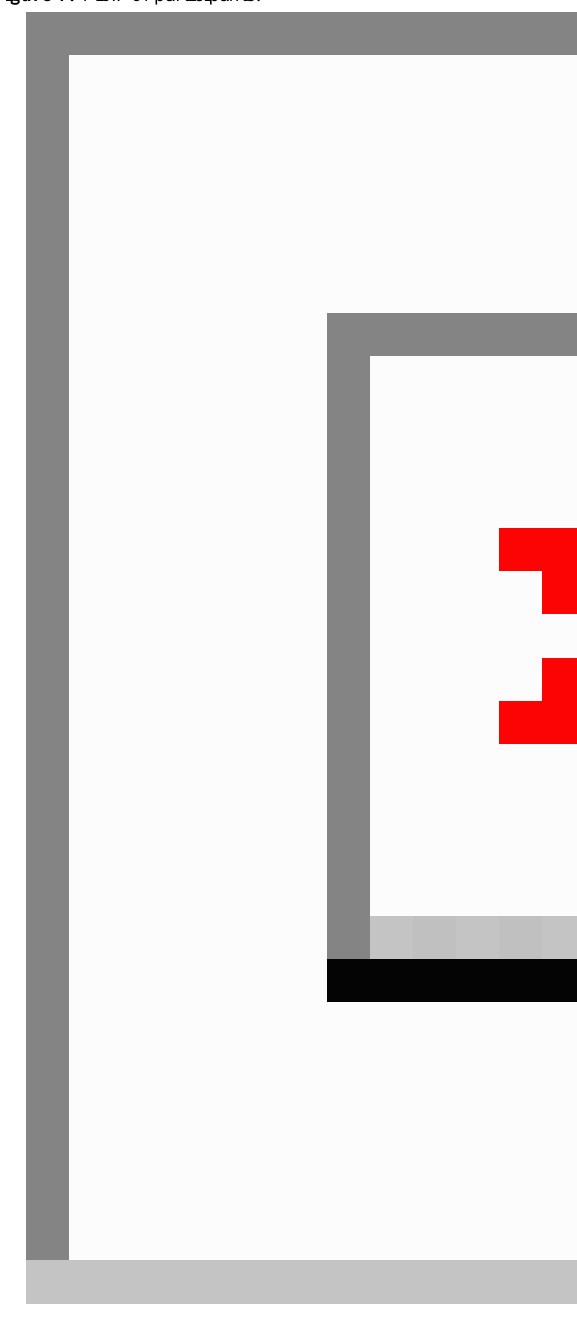
Figure 1. Flow of